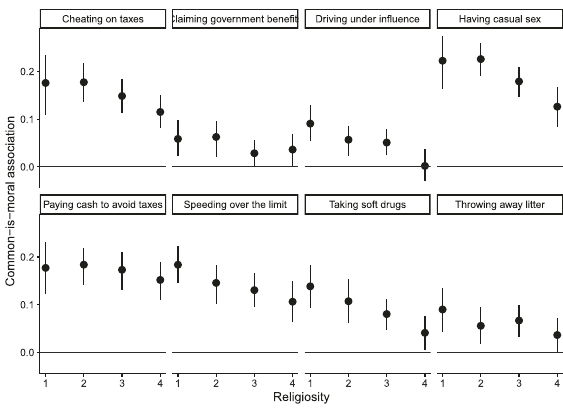
Fig. 5 How the between-individual common-is-moral association depended on religiosity. For each of the eight focal behaviours, the graph shows the mean value, with a 95% bootstrap con fi dence interval, of the between- individual common-is-moral association in four subsamples of participants de fi ned by their response to the importance of religion (1 = not at all important, 2 = not important, 3 = quite important, 4 =